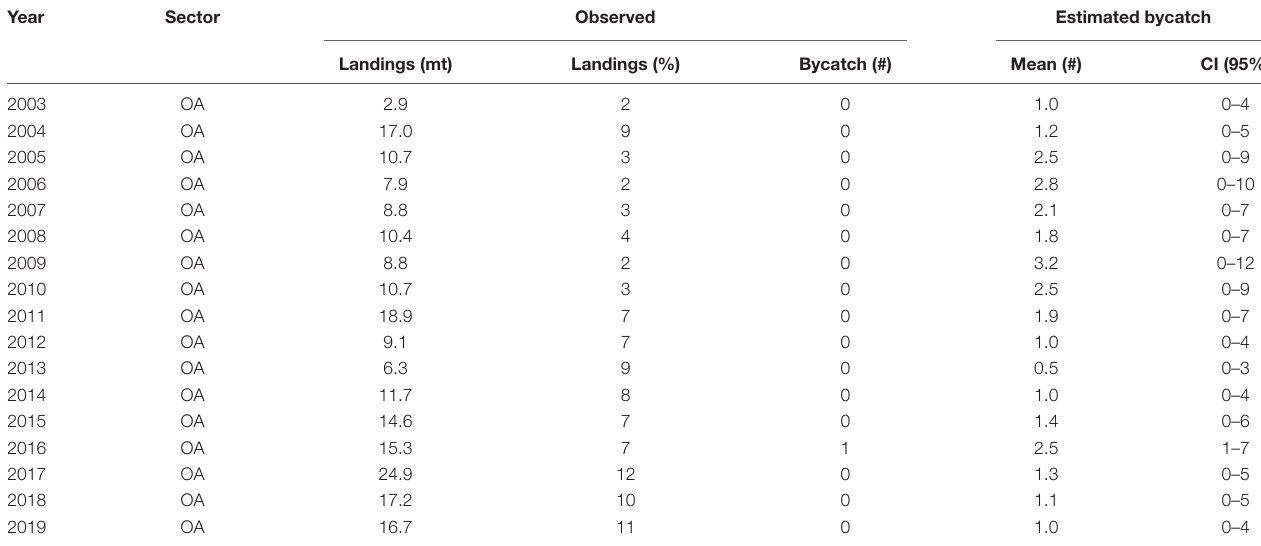
TABLE 3 | The data used to calculate humpback whale bycatch in the OA sablefish pot fishery collected by fishery observers (observed) and the estimated mean and 95% credible interval (CI: lower–upper) from the best model. The best model included a constant bycatch rate, a Poisson count process, and used the total weight (mt) of landings from all trips that carried an observer (observed) as fishing